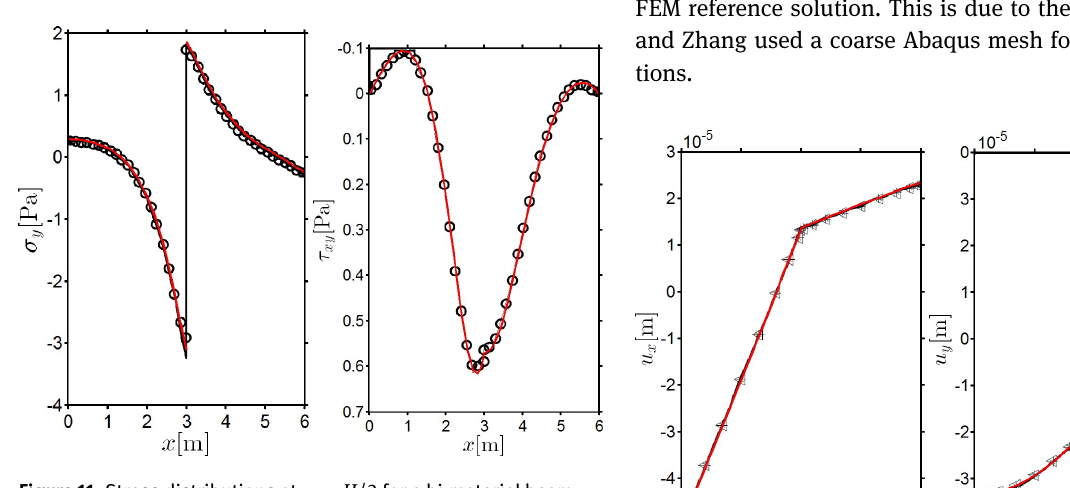
Figure 11: Stress distributions at y = H /2 for a bi-material beam.